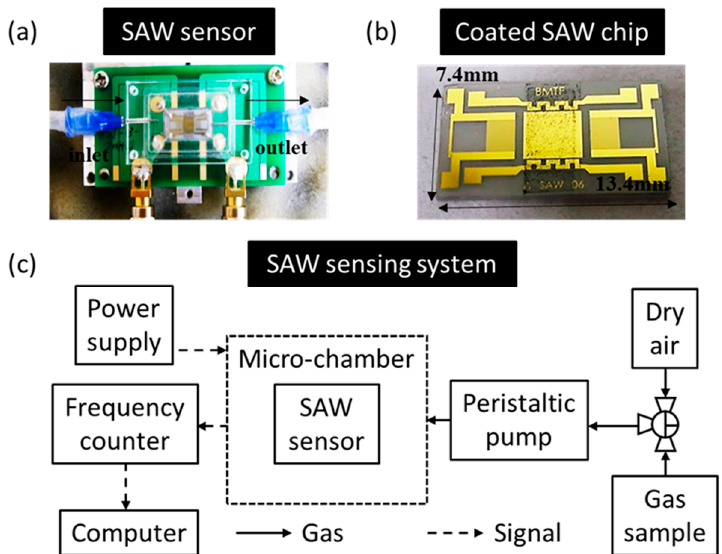
Figure 1. ( a ) Image of surface-acoustic-wave (SAW) sensor with a micro-chamber. ( b ) Spin-coated SAW chip with oxidized hollow mesoporous carbon nanospheres (O-HMC). ( c ) Schematic diagram of SAW sensing system.